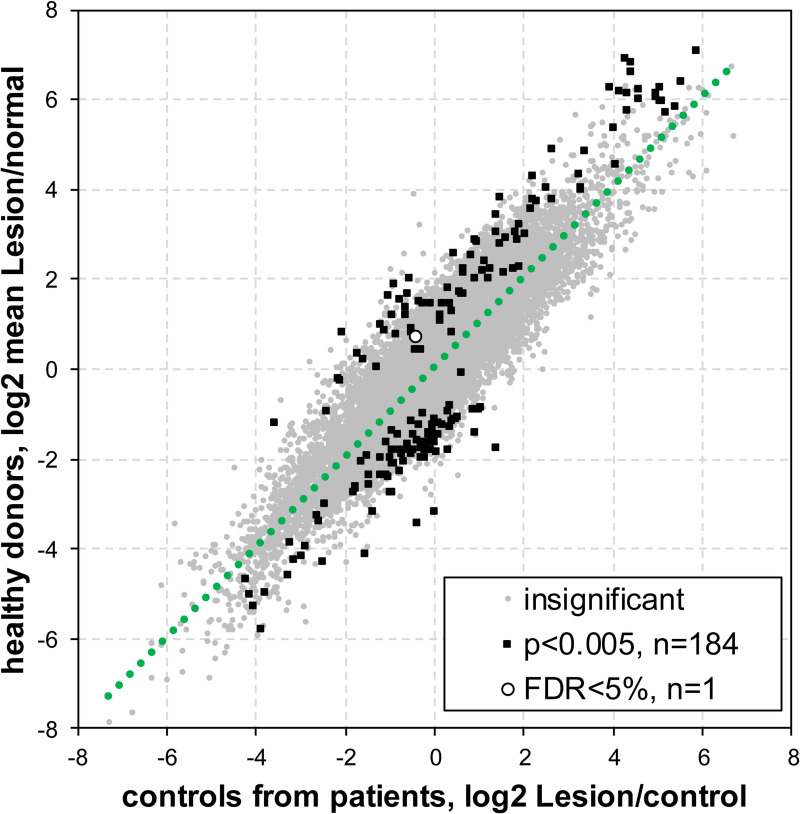
Comparison of cellular gene expression between healthy donors’ skin and control skin from KS patients in a context of differences versus KS lesion.(A) Scatter plot of Lesion/control (mean lesion/mean control from the same patient) and Lesion/normal (mean lesion of all the patients/mean healthy skin samples) expression log2-ratios. Regression line is shown as a green dotted line. Gray dots indicate genes whose expression was not significantly different (p>0.005) between healthy skin from donors and control skin from KS patients, squares show genes whose expression was significantly different between healthy skin from donors and control skin from KS patients at P<0.005 (N = 184) with red indicating up- and blue–down-regulation in control as compared to normal skin. Circle marks gene with expression significantly different between healthy skin from donors and control skin from KS patients at FDR<5% (N = 1). FDR–False discovery rate.